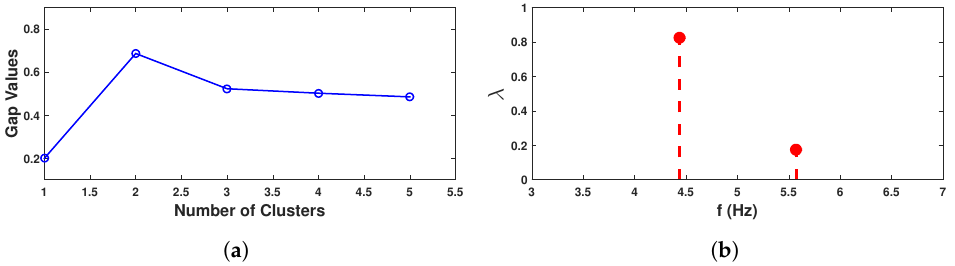
Figure 4. Clustering; ( a ) Gap statistics for optimal cluster & ( b ) Weights of each cluster.